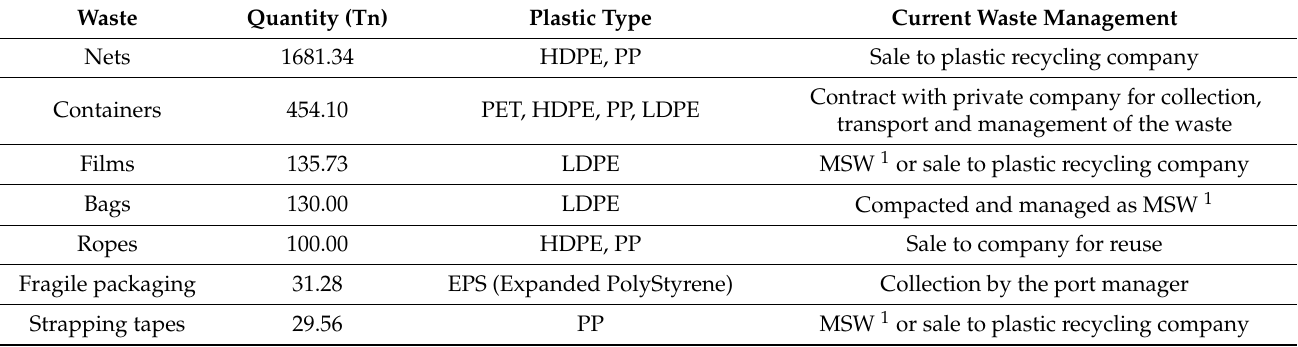
Table 1. Summary of the main plastic waste data.